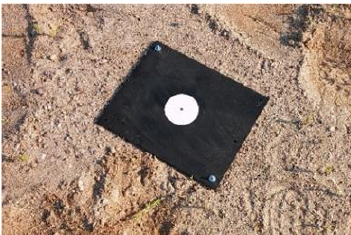
Figure 2. The artificial markers used